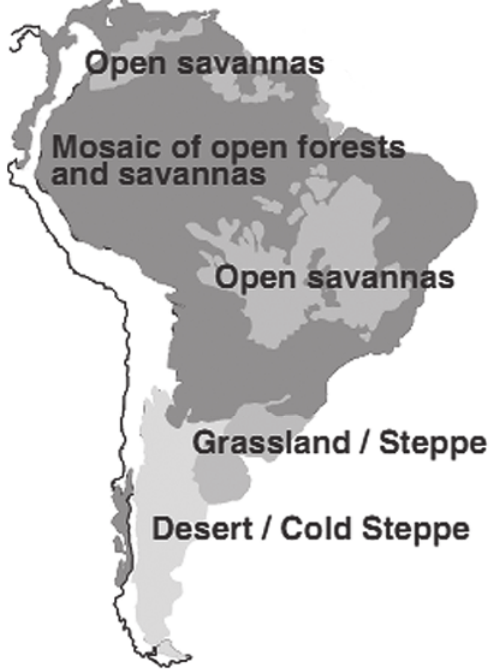
Fig. 23 - Distributional pattern of vegetation during the Pleistocene (modifi ed from de Vivo and Carmignotto